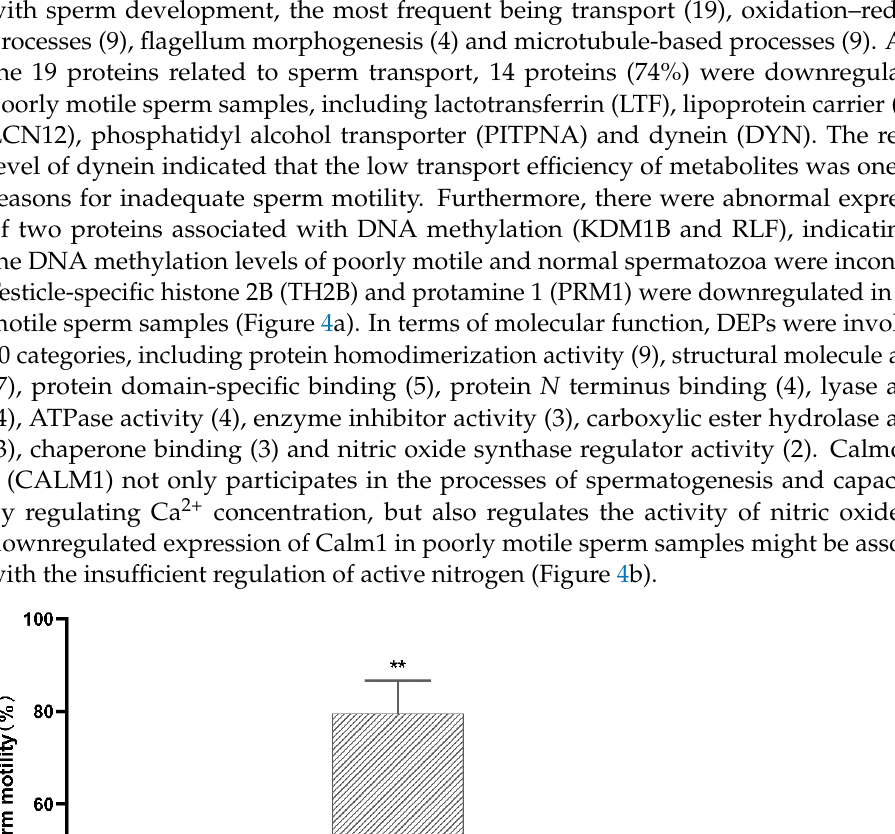
Figure 2. Venn diagram of sperm proteomic replicates. Replicate 1 detected 1148 proteins (blue), Replicates 2 detected 1171 proteins (red), and 981 proteins (purple) were replicated twice.